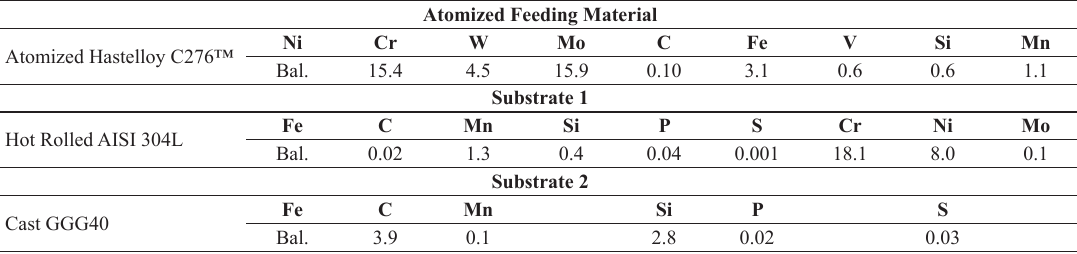
Figure 1. SEM image of the gas atomized Hastelloy C276™ Table 1. Materials chemical composition (wt.%)